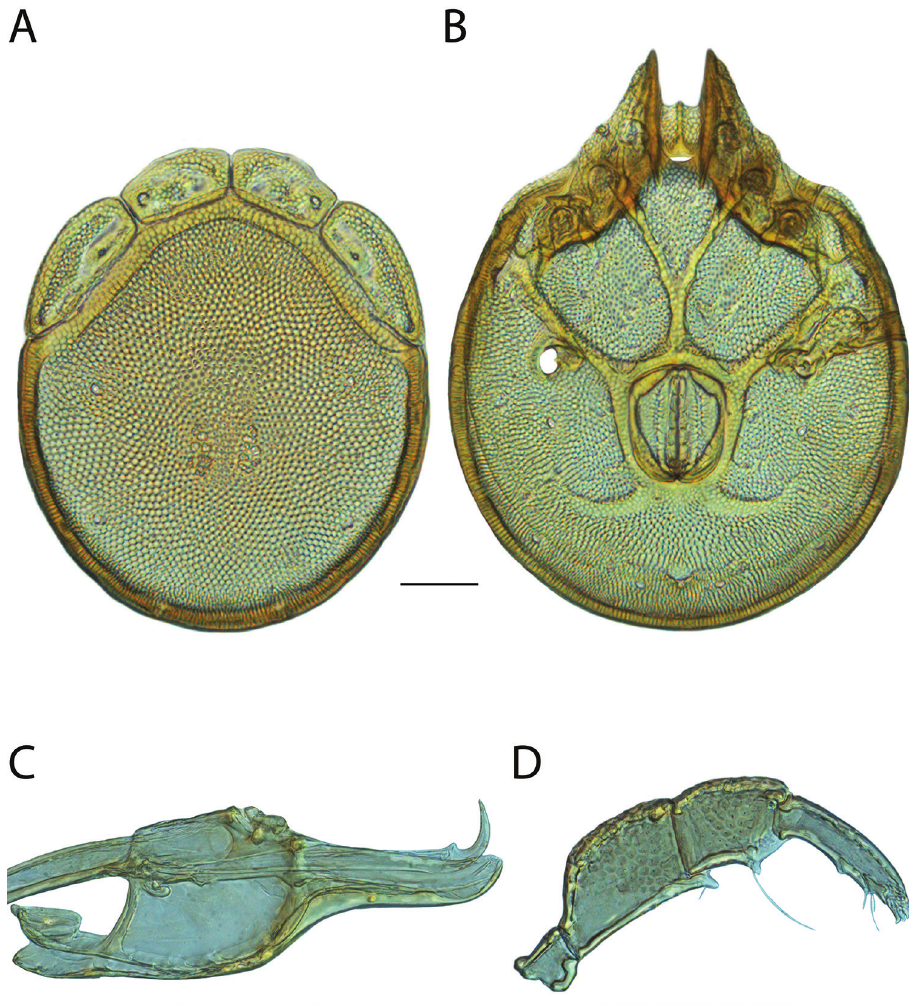
Figure 280. Torrenticola wiedenmanni sp. n. male: A dorsal plates B venter (legs removed) C subcapitulum D pedipalp (setae not accurately depicted). Scale = 100